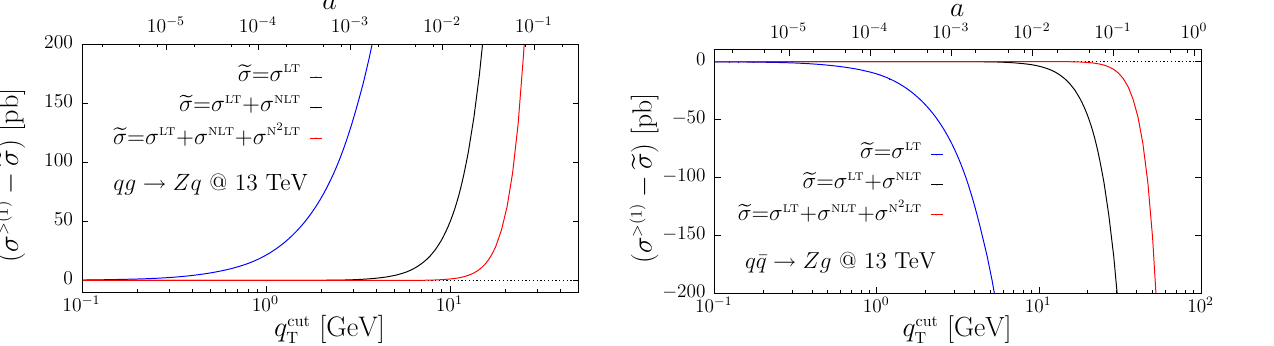
(cid:10) (cid:9) 2 are / m q cut Z T